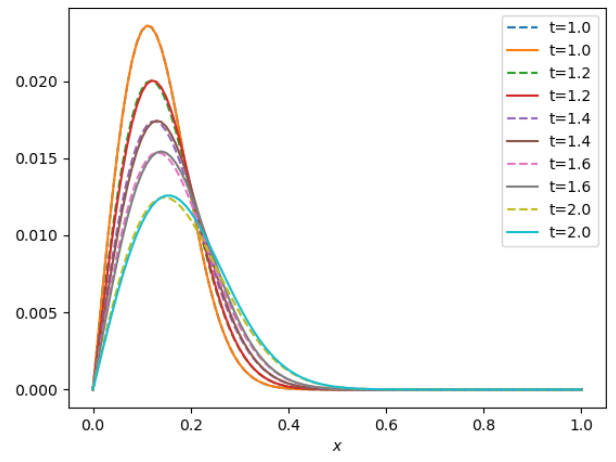
Figure 9. Shock propagation ν = 0.005 and N = 100.